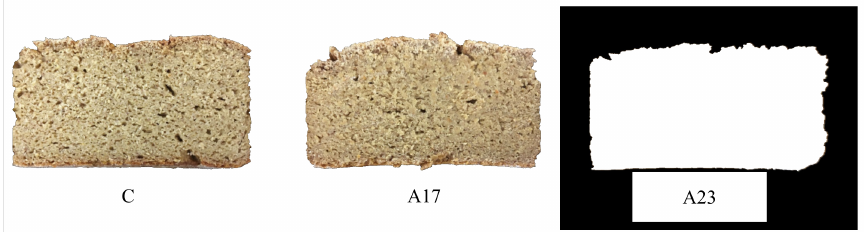
Figure 2. GF breads: (C) control, without apple flour, (A17) with 17%, and (A23) with 23% apple flour addition.